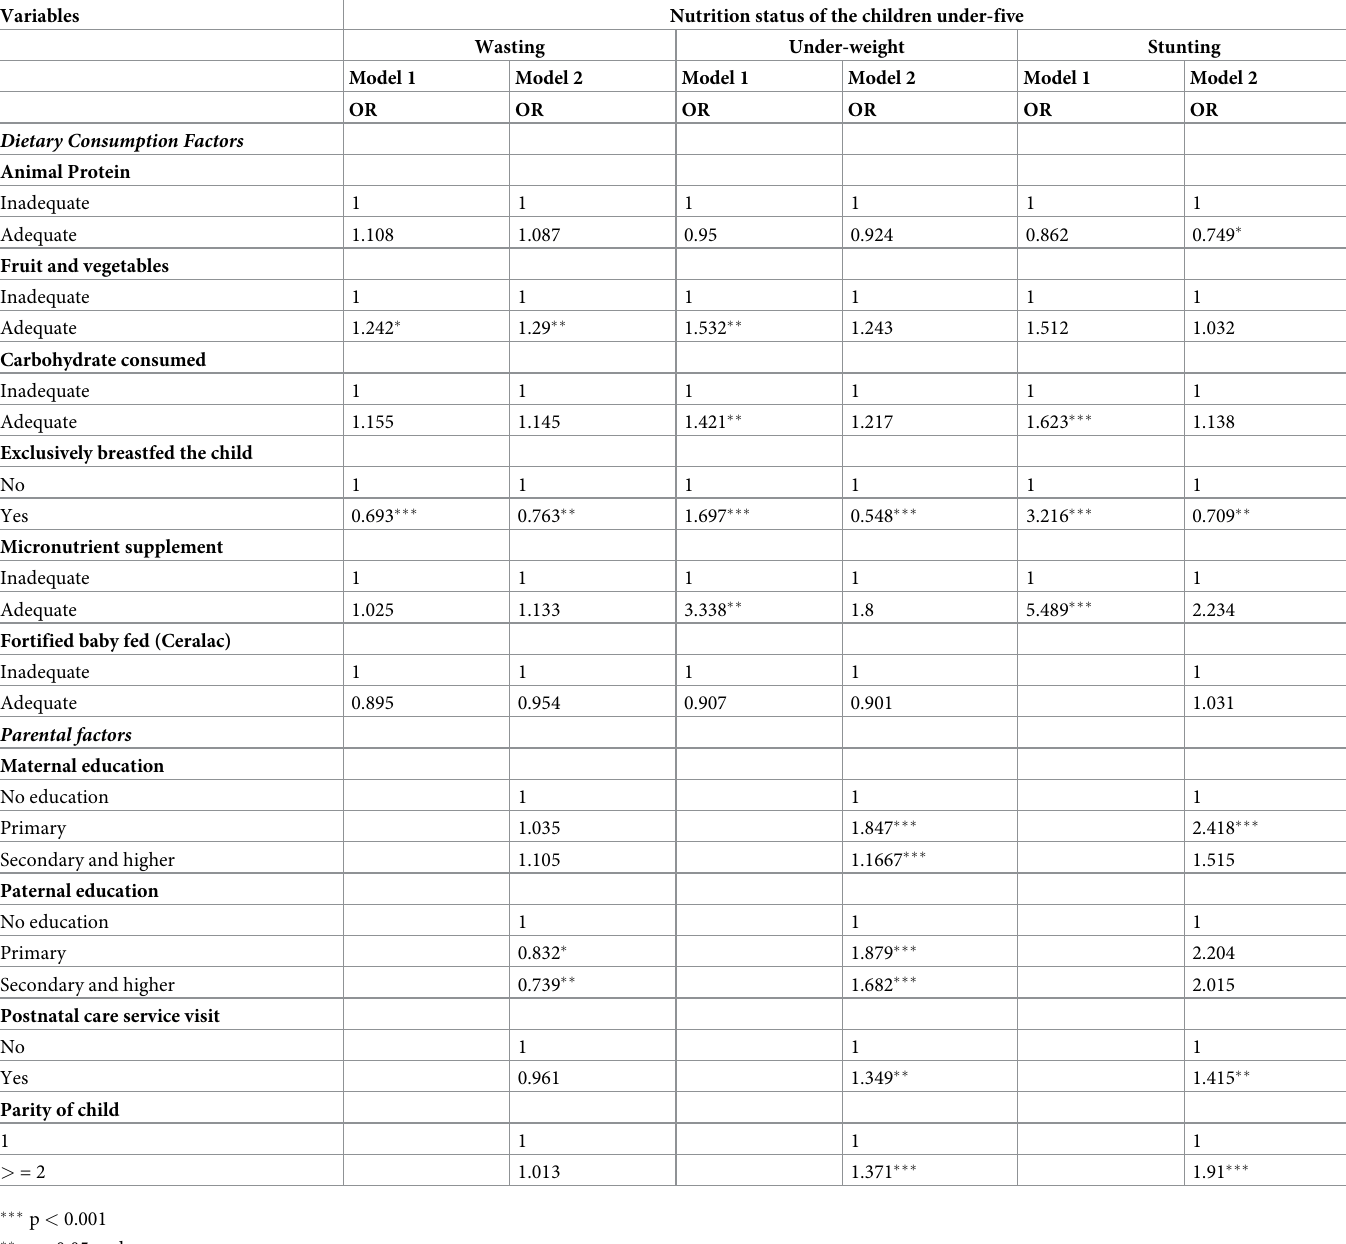
Table 3. Nested logistic regression estimating factors influencing nutritional status of rural children under-five in